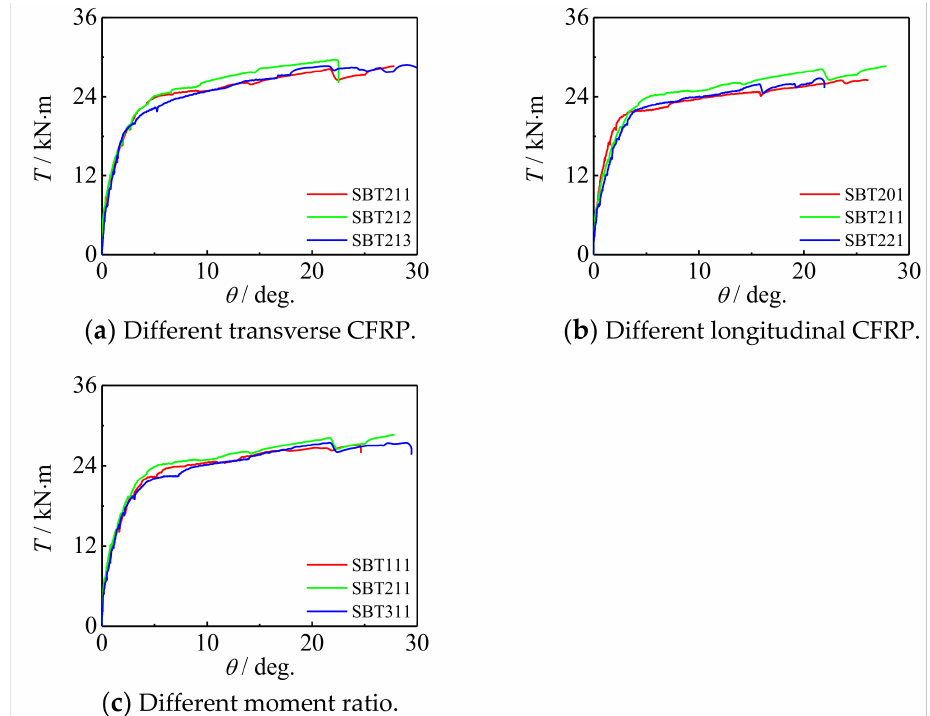
Figure 7. T - θ curves of square section specimen.